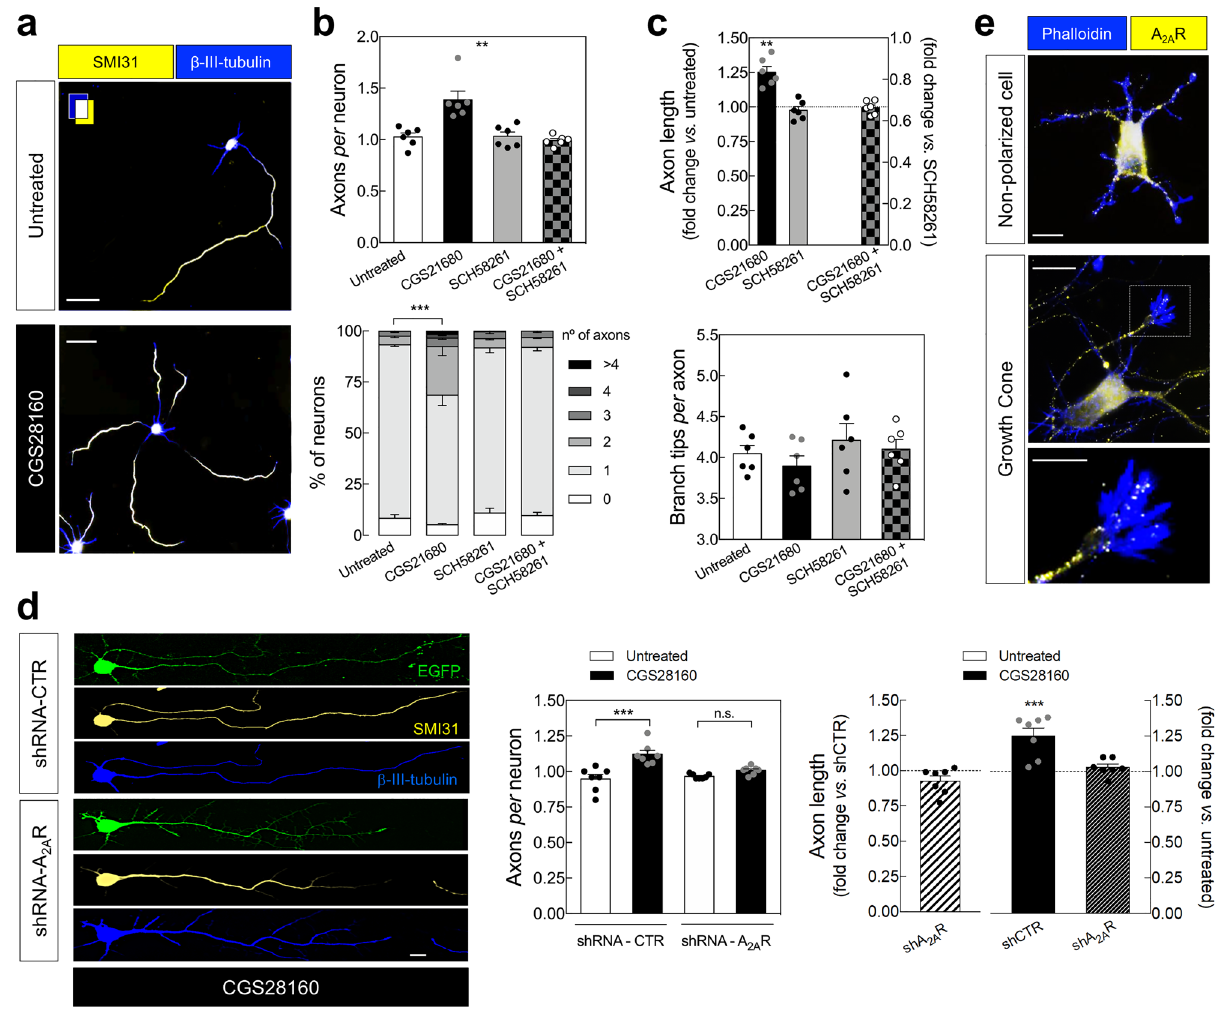
Figure 1. Pharmacological activation of A 2A Rs induces the formation of abnormal secondary axons in cultured hippocampal neurons. ( a ) Representative images of E18 rat-derived hippocampal neurons cultured in the absence and in the presence of the selective agonist of A 2A Rs, CGS21680 (30 nM), from DIV0, double immunolabeled with SMI31 (axonal marker; yellow) and βIII-tubulin (neuronal marker; blue) antibodies at DIV 3 (scale bar, 30 µm), showing that ( b ) the exposure to CGS21680 increased the number of axons per neuron (upper graph), reflecting an increased percentage of neurons with multiple axons (lower graph). The selective antagonist of A 2A Rs, SCH58261 (50 nM), did not modify the average number of axons per neuron, but prevented the ability of CGS21680 to modify the number of axons per neuron. ( c ) CGS21680 increased axonal length (in those cells displaying more than one axon, it was counted the longest axon), whereas SCH58261 was devoid of effects. In the presence of SCH58261, CGS21680 did not modify axonal length. Neither CGS21680 nor SCH58261 significantly modified axonal branching. Data are mean ± SEM quantified from 6 independent cultures, analyzing a minimum of 100 cells per culture and condition. ( d ) In cells electroporated at DIV0 with either shRNA-Control (shCTR) or shRNA-A 2A R (shA 2A R) (EGFP + ), CGS21680 increased the number of axons per neuron and axonal length in cells transfected with shCTR but not in cells transfected with shA 2A R. Scale bar, 10 μm. Data are mean ± SEM quantified from 7 independent cultures, analyzing a minimum of 25 transfected cells per culture and condition. ** P < 0.01 and *** P < 0.001. ( b upper ; c lower) one-way ANOVA with Dunnet’s post-hoc test; ( b lower ; d left ) two-way ANOVA with Sidak’s post-hoc test; ( c upper ; d right ) one-sample t -test vs. hypothetical value of 1. ( e ) Immunocytochemical analysis of A 2A R immunoreactivity (yellow) in a non- polarized neuron and in an axonal growth cone labelled with phalloidin (blue). Scale bar for upper and middle image, 10 μm; scale bar for the lower image, 5